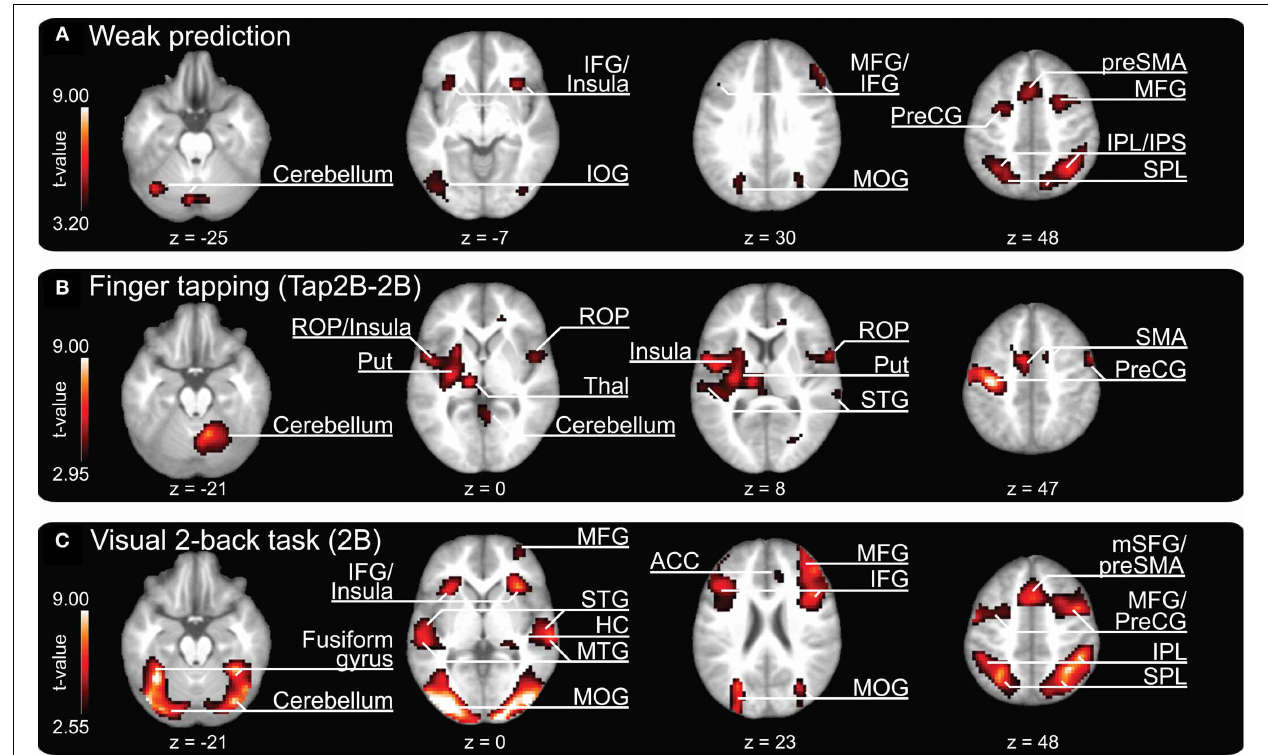
FIGURE 4 | Clusters of increased brain activity related to (A) weak temporal prediction (i.e., negative covariation with prediction/tracking ratios) and activation clusters revealed during (B) finger tapping (contrast “Tap2B-2B”) and (C) 2-back object comparisons and auditory perception of a pacing signal (2B). The depicted activations are significant at a threshold of p < 0 . 05, FDR corrected. Results are displayed according to neurological convention. Color codes correspond to t -values as shown in each panel. The z -coordinates are given according to MNI space and